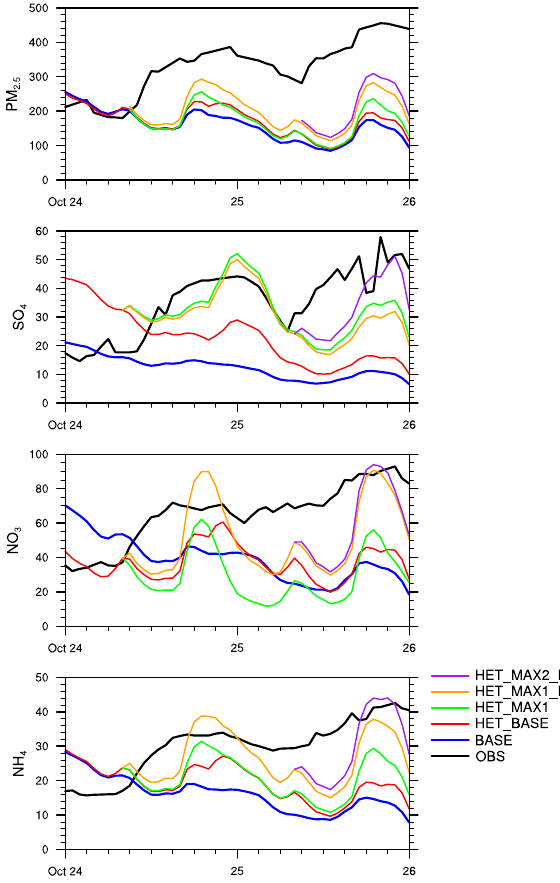
Figure 9. The sensitivity simulations of PM 2 . 5 and SNA species (µgm − 3 ) for the 24–25 October pollution